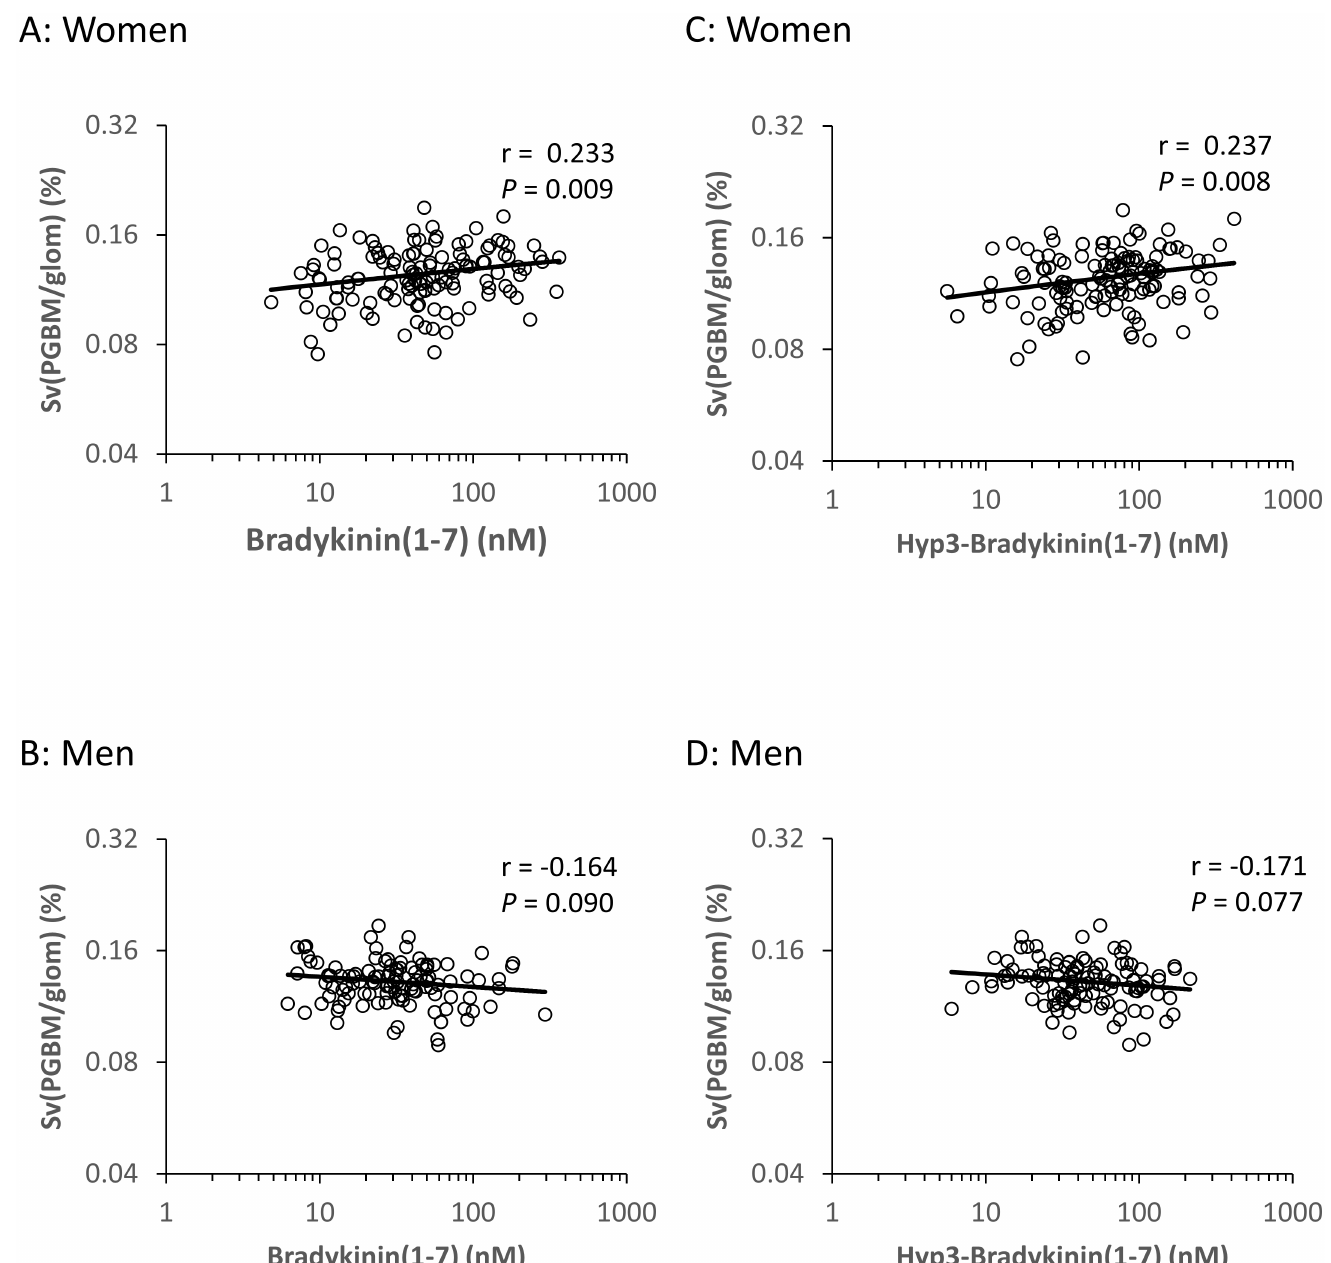
Fig 1. Associations of baseline plasma BK(1–7)and hyp3-BK(1–7) with baseline Sv(PGBM/glom) in the 130 women and 116 men from RASS. Residualswere computedby regressing each of the variableson baselineage, durationof diabetes, HbA1c, mean arterial pressure, and treatment assignment. Residualsare plotted on logarithmic